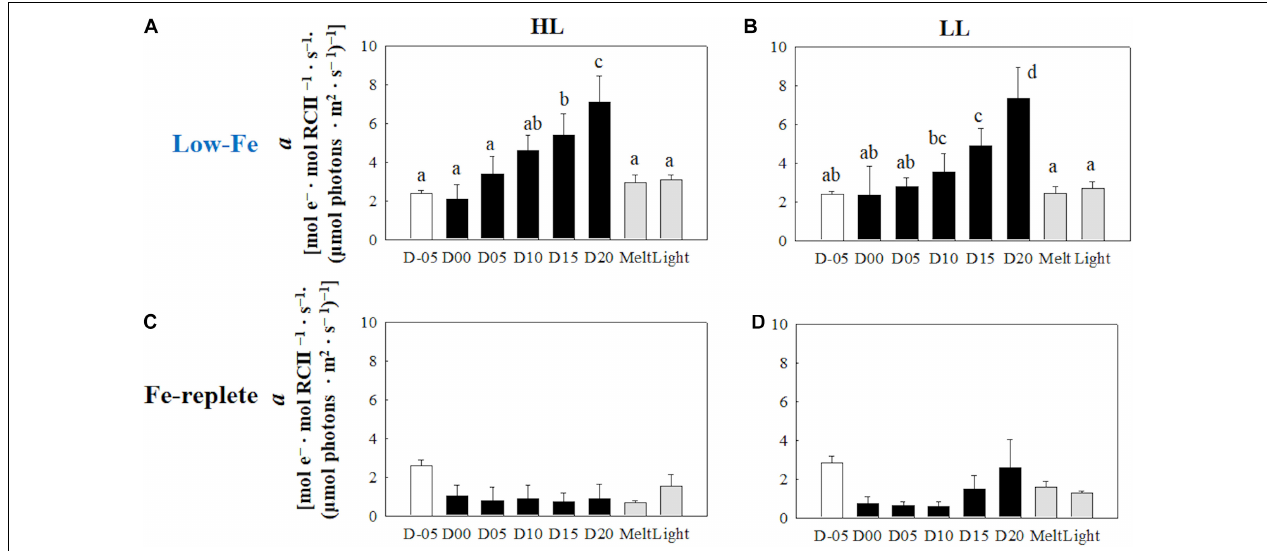
FIGURE 6 | Light utilization index ( α ) calculated from the photosynthesis-irradiance (ETR RCII - E ) relationship at each sampling time point during the ice tank incubation experiments. Panels (A,B) show α values of the low-Fe ice tank runs in this study, whereas panels (C,D) show those of Fe-replete ice tank runs modified from Yoshida et al. (2020). Left (A,C) and right (B,D) panels indicate data from the HL and LL treatments, respectively. Open, closed, and shaded bars indicate values of pre-freeze seawater, ice, melted seawater samples, respectively. Letters above bars in a panel indicate significant differences in values between sampling days with one-way ANOVA with Tukey’s test; there is no significant difference between values if a given letter is shown in the combination of letters of the counterparts. The D stands for “day,” while Melt and Light indicate values after melting and light exposure experiments, respectively. Error bars show 1 standard deviation ( n = 6). One-way ANOVA with Tukey’s test, HL: F ( 7 , 47 ) = 26.84, p < 0.001; LL: F ( 7 , 47 ) = 21.03, p < 0.001. Two-way ANOVA test with Tukey’s test, Light: F ( 1 , 90 ) = 3.68, p > 0.05; Day: F ( 7 , 90 ) = 36.02, p < 0.001; Light*Day: F ( 7 , 90 ) = 0.88, p > 0.05. The results of Tukey’s test, as q -values, are given in the